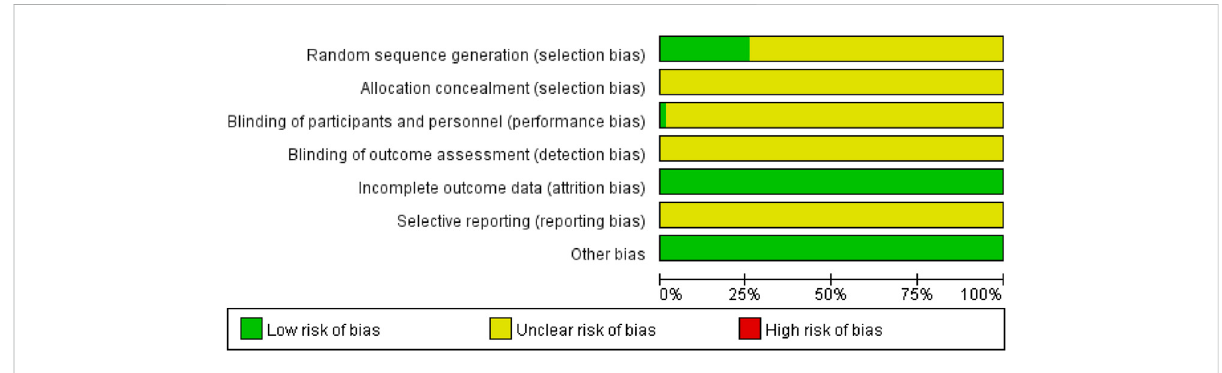
FIGURE 2 Results of risk of bias evaluation of included